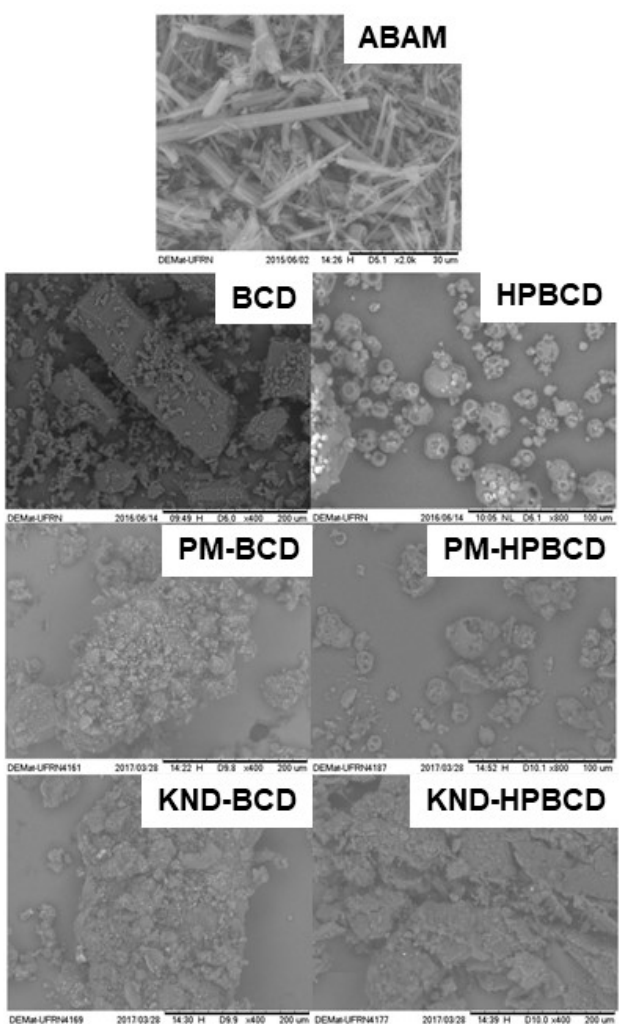
Figure 2. Scanning electron microscopy (SEM) micrographs of ABAM, β CD, HP β CD as well as ABAM- β CD and ABAM-HP β CD prepared by PM and KND methods with magnifications of 400 × and 2000 ×